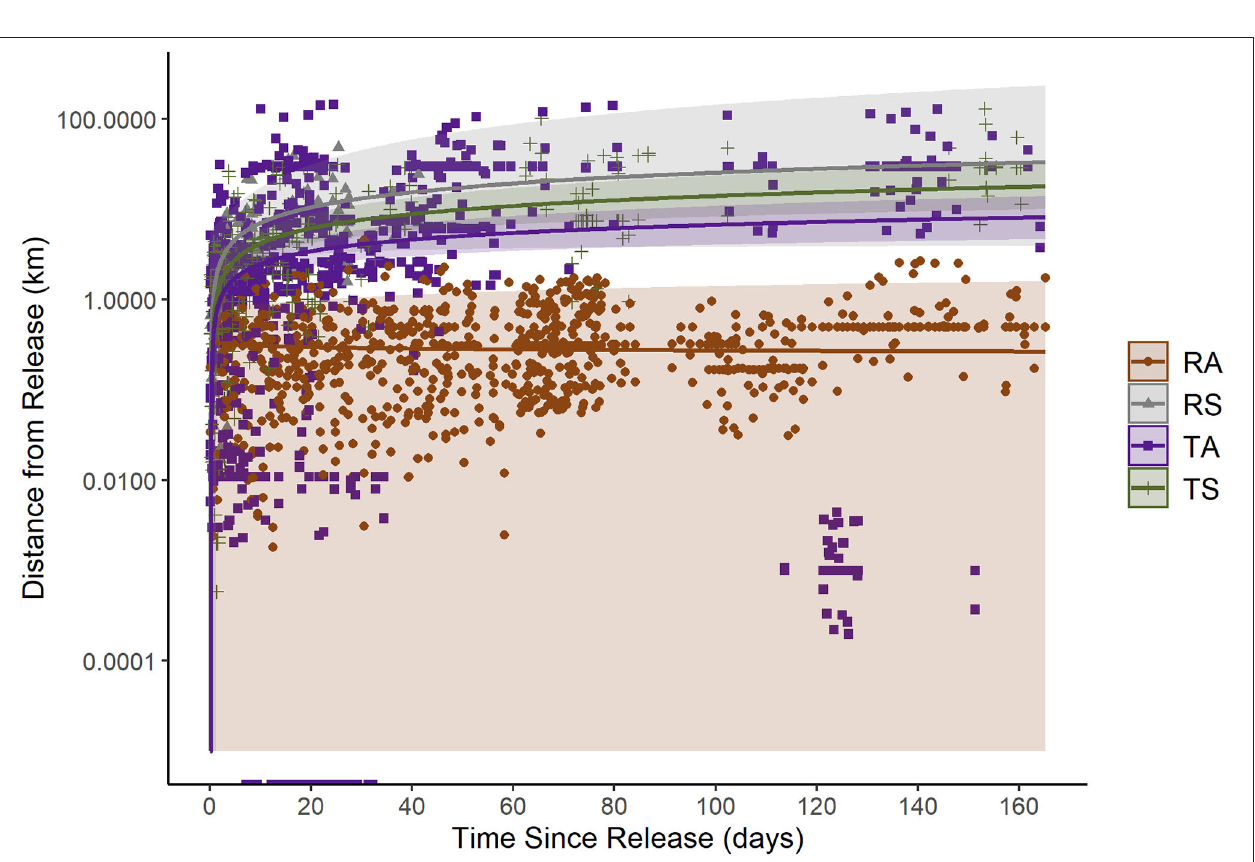
FIGURE 2 | antennae (PIAs) outside of or near the end of the passive restoration sites. The color of the river line indicates which release site translocated beavers originated from (Moonshine Wash or Price River) a ; 36.6% ( n = 15) of translocated beavers were not detected by the labeled PIAs (Pa-Pd or Ma-Mb), and 17.1% ( n = 7) of translocated beavers were detected at more than one of the labeled PIAs. a Distance each PIA is from each release site: Pa, 101km from Price River release site; Pb , 7km from Price River release site; Pc , 29km from Price River release site; Pd , 47km from Price River release site; Ma , 58km from Moonshine Wash release site; Mb , 5km from Moonshine Wash release site .